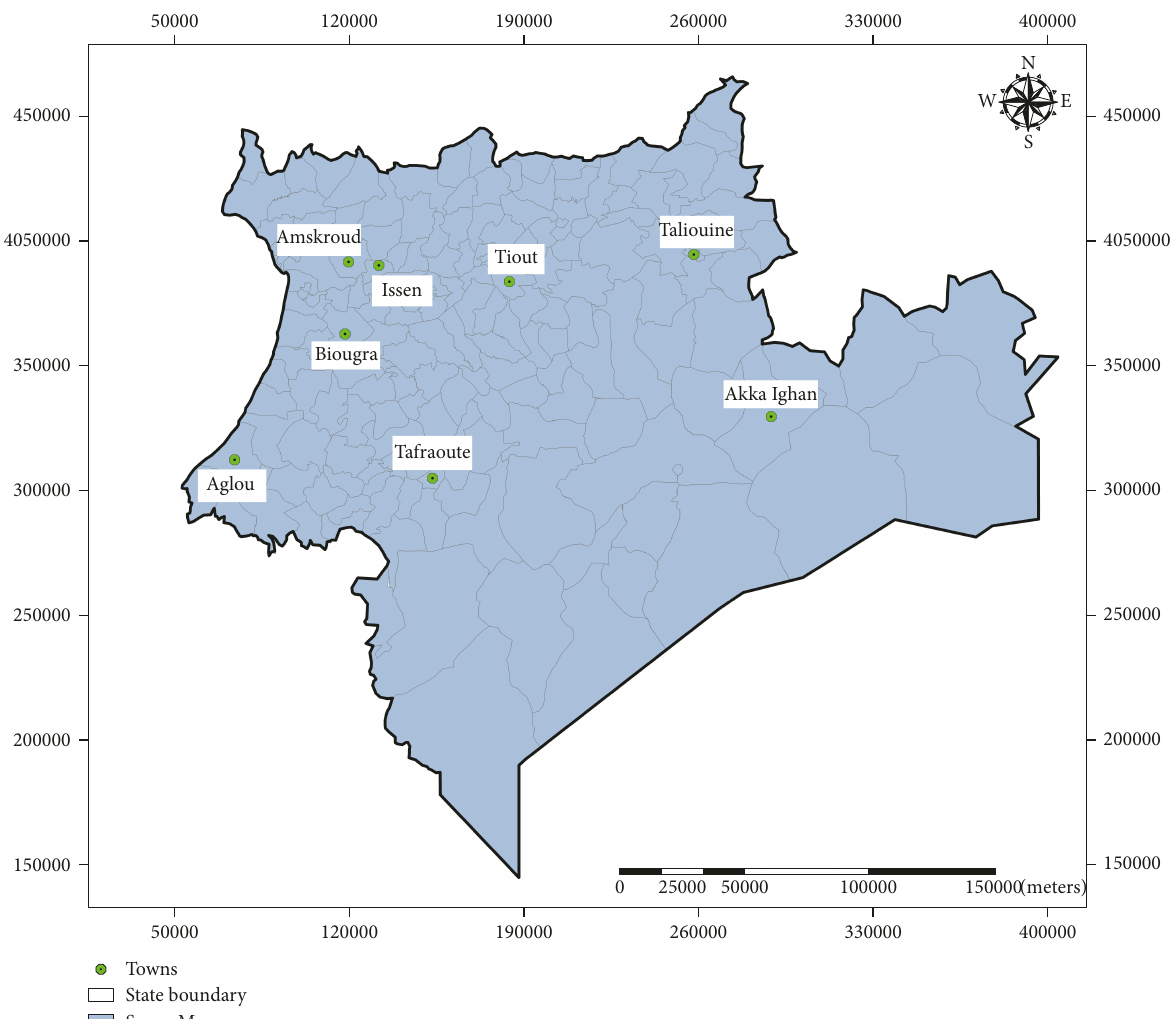
Figure 5: The geographical locations used in the test under di ff erent climatic